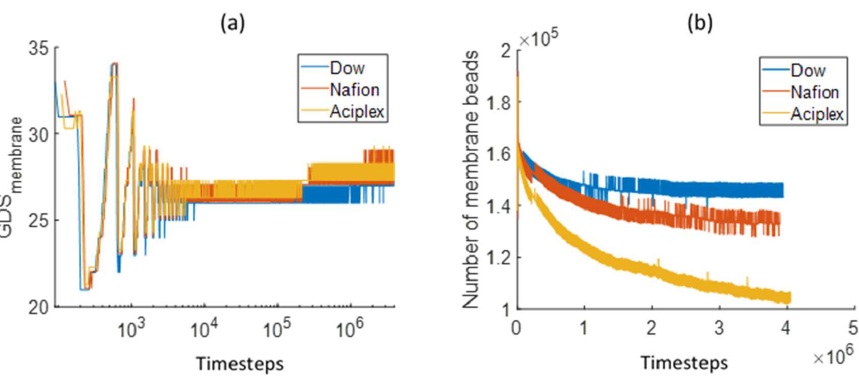
Figure 5. Comparison of ( a ) the temporal evolution of the membrane Gibbs dividing surface (GDS) and ( b ) time dependence of the number of membrane beads between the GDS membrane and bottom Z boundary for different side-chain length PEMs.